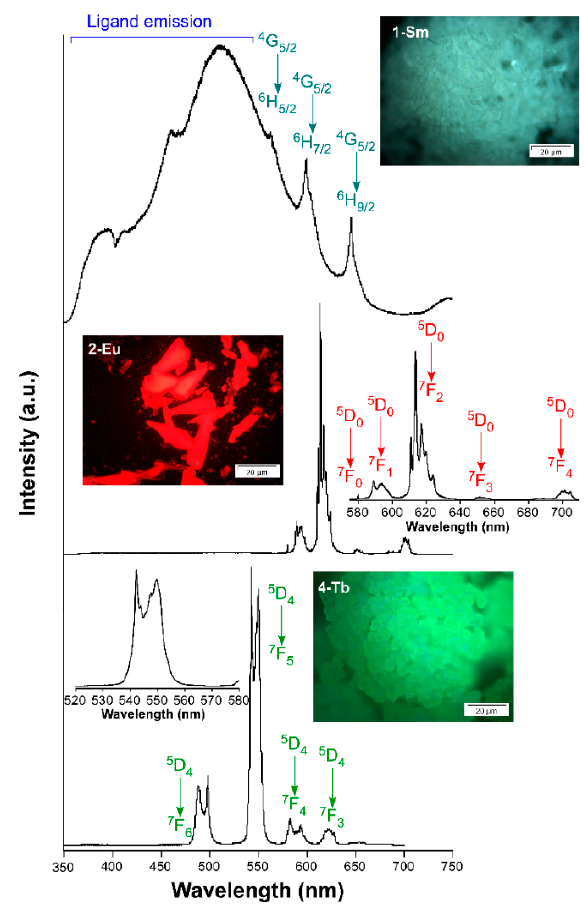
Figure 3. Emission spectra of compounds 1 Sm , 2 Eu and 4 Tb recorded at room temperature showing the intraionic assignations. Insets show selected augmented regions corresponding to the main intraionic transitions and ligand-centered emission.